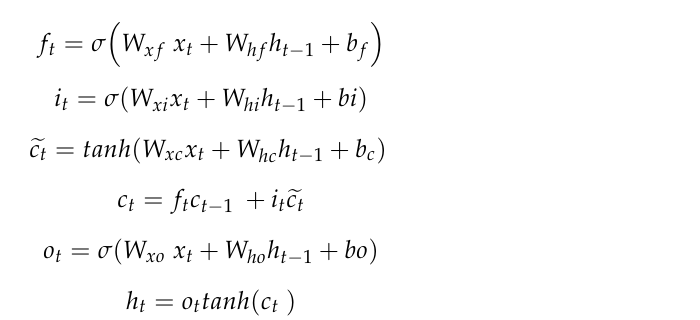
Figure 1. The structure of three gates in the Long Short-Term Memory (LSTM) cell.